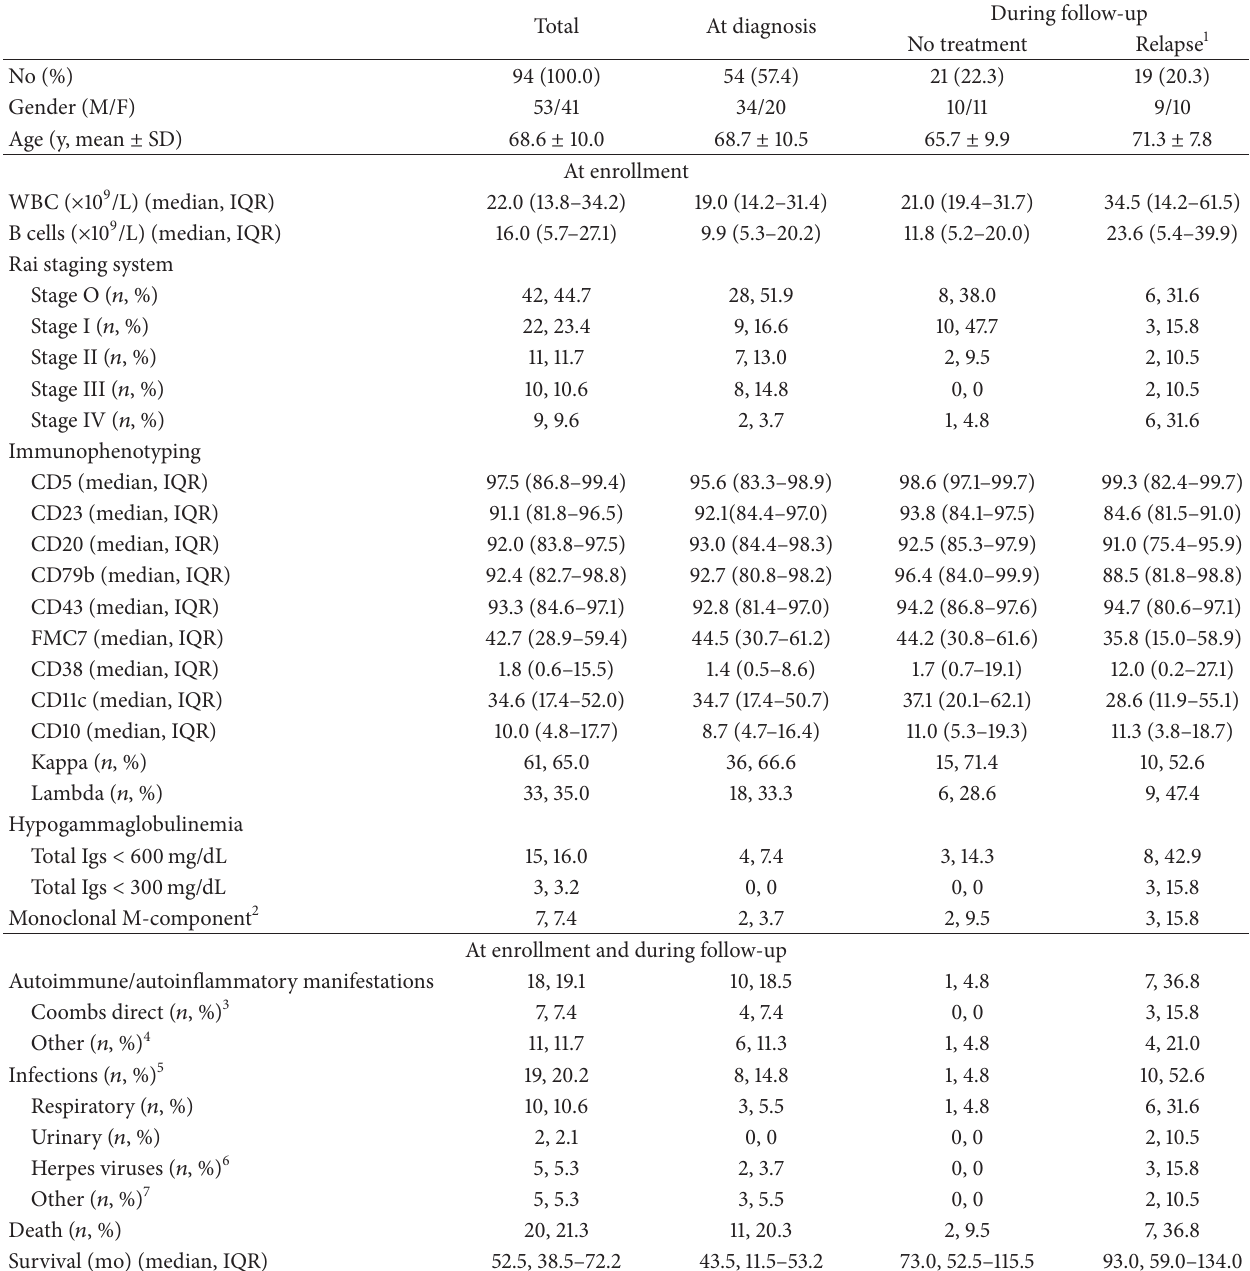
Table 2: Overview of clinical and laboratory characteristics of the patients of the